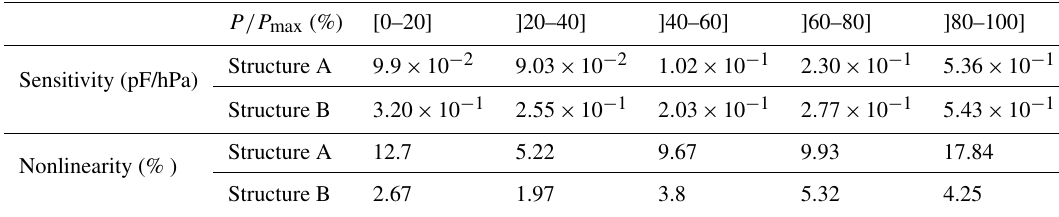
Figure 9. Responses obtained of the 3D-printed capacitive sensors at ambient temperature. (a) Responses of the sensor with C 0 fixed; the orange curve corresponds to the practical response, while the blue one corresponds to the theoretical results. (b) Responses of the sensor with C 0 variable; the orange curve corresponds to the practical response, while the blue one corresponds to the theoretical results. Table 4. Sensitivity and nonlinearity of the fabricated